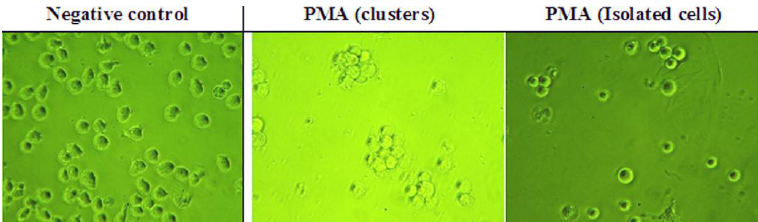
Figure 3. Effect of phorbol-12-myristate-13-acetate (PMA) on U937 cells. PMA was added to the cells at 60 ng/mL ( n = 3). (Magnification = ×400).